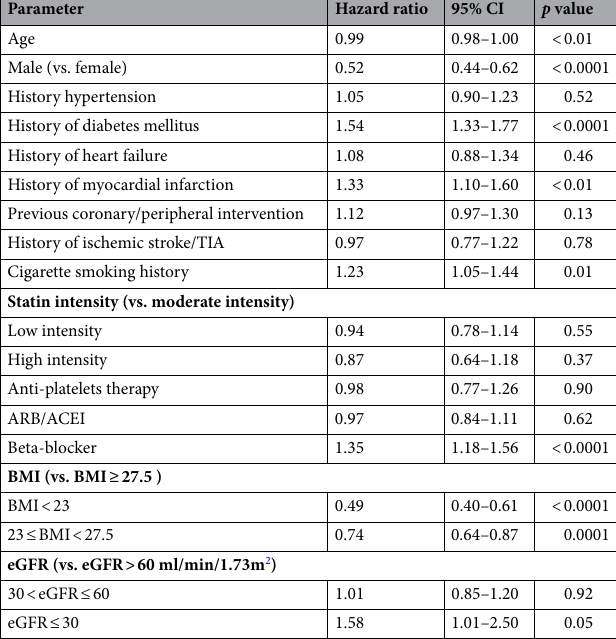
Table 2. Multivariate analysis for predicting factors of low HDL-C. *Abbreviations are the same as the Table 1. eGFR, estimated glomerular filtration rate.